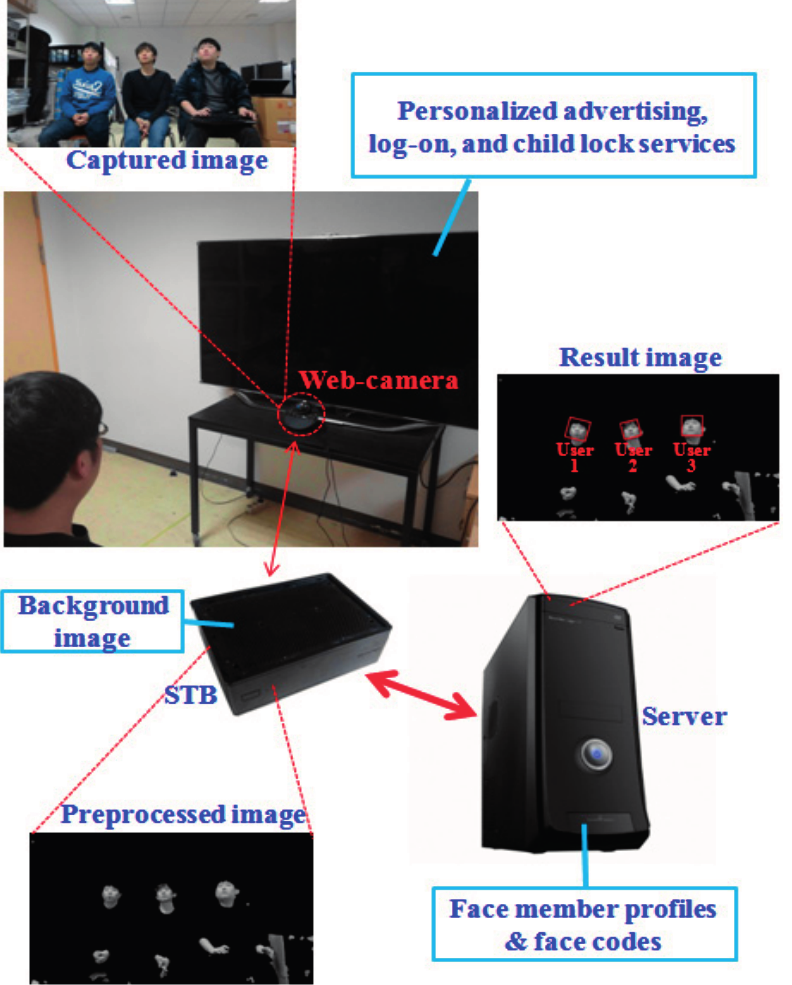
Figure 1. Proposed face recognition system for digital TV with supplementary